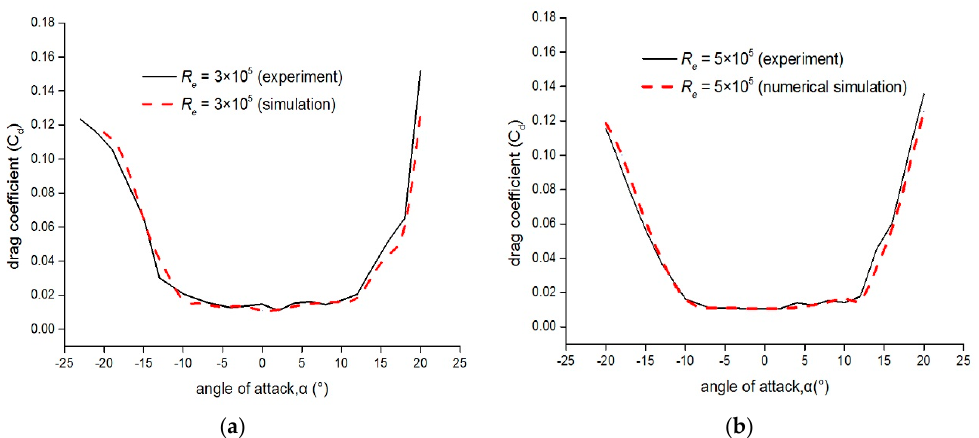
Figure 10. Drag coefficient for the LUT airfoil at different values of R e : ( a ) the case of R e = 3 × 10 5 ; and ( b ) the case of R e = 5 × 10 5 . The lines in black and red of the drag coefficient correspond to the experimental results and the numerical simulation results, respectively.